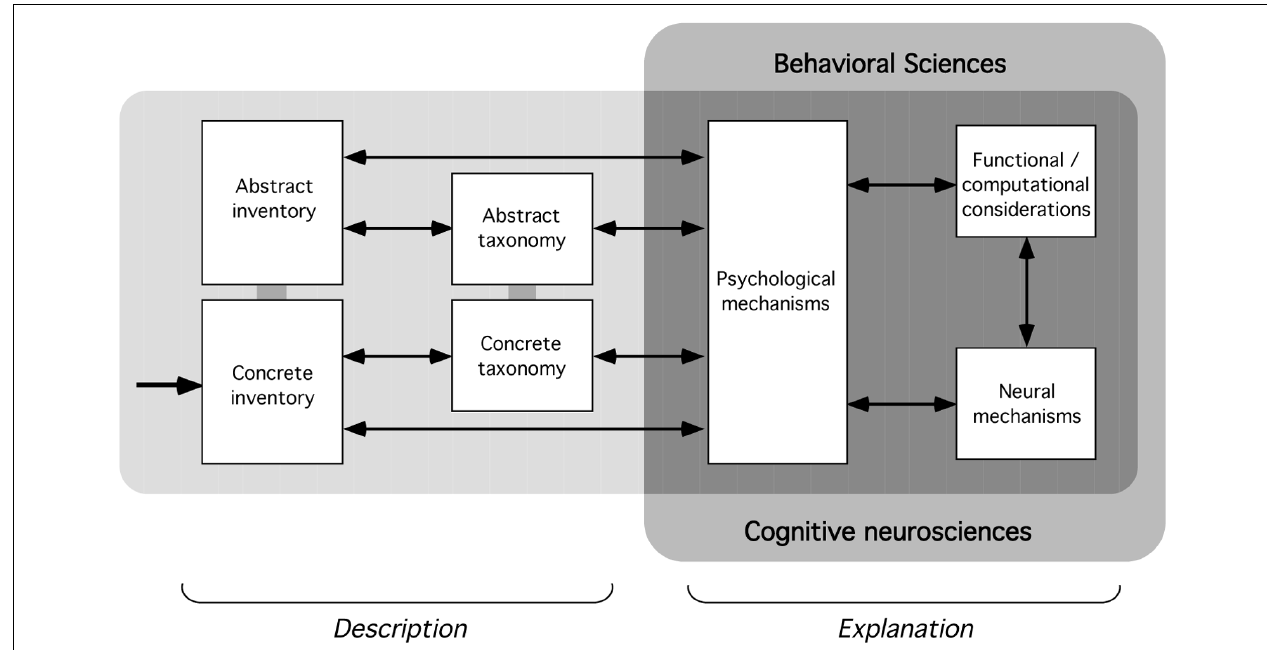
FIGURE 3 | Framework for a possible science of magic. Each part concerns a particular set of related issues.The arrow indicates that investigation would begin with the collection of individual tricks the concrete inventory; these could be abstracted and collected into an abstract inventory (see Inventory),